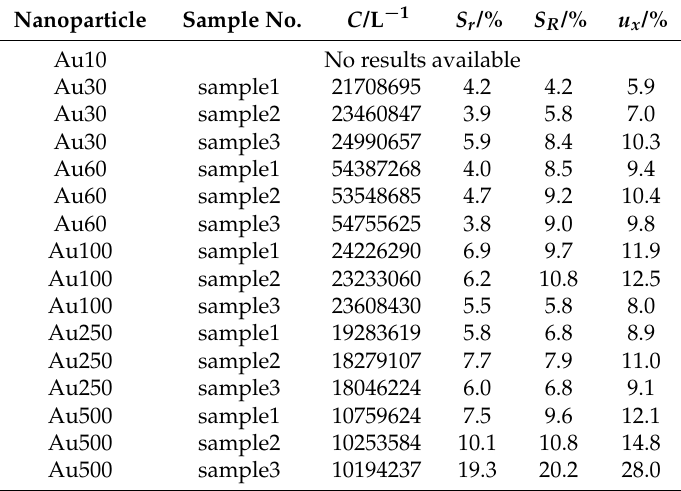
Table A3. Repeatability, reproducibility and calculated measurement uncertainty for the analysis of the Au nanoparticles. The results are calculated for each individual and independent sample, even if they are analyzed on the same day. The number concentration is given as measured in the diluted